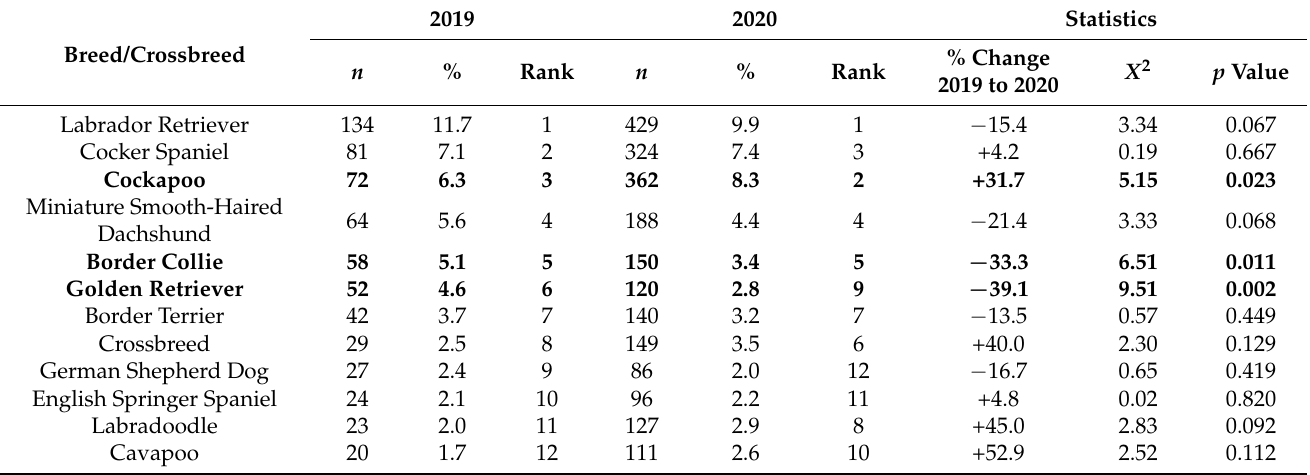
Table 1. Most popular individual breeds/crossbreeds in the 2019 puppy ( n = 1147) and Pandemic Puppy ( n = 4358) cohorts. Crossbred dogs were defined as mixed breeds of unknown origin, or crosses who were not reported using a breed-indicative designer crossbreed name, e.g., Spaniel Cross. The breeds with the greatest frequency, which formed the top ten most popular breeds for each of the 2019 puppy and Pandemic Puppy cohorts, are shown along with their ranking (1 = most popular) for each year. The p value reflects the probability of a difference in popularity for the breed/crossbreed between 2019 to 2020. Significant differences are